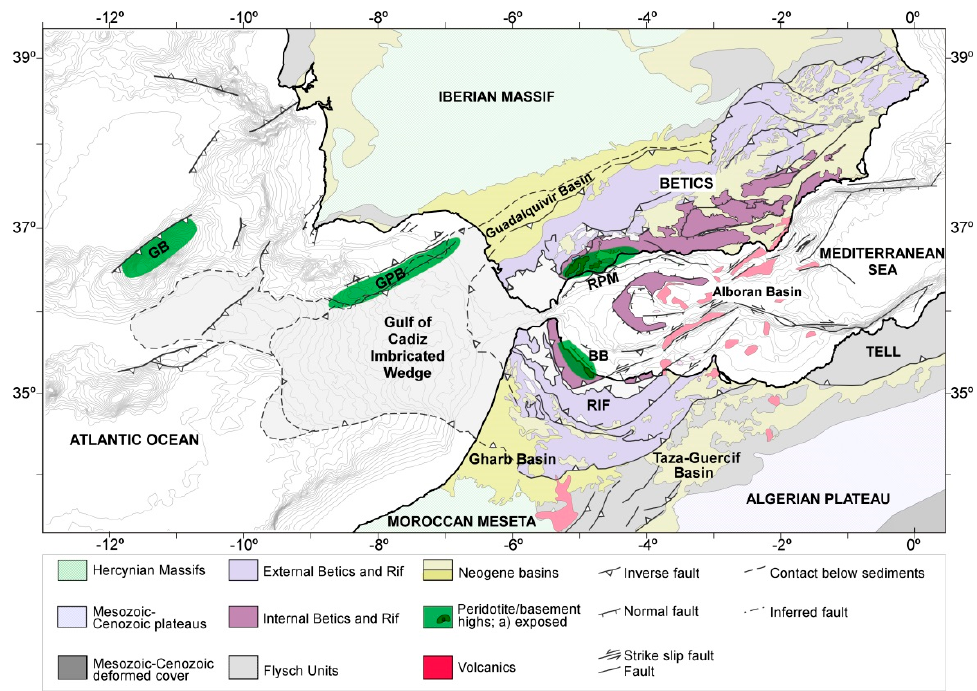
Figure 1. Simplified geologic and tectonic map of the Iberia–Africa plate boundary region modified from the works of [13,14]. Shaded green areas denote main compressive structures with outcropping or in-depth exhumed mantle rocks. GB: Gorringe Bank; GPB: Guadalquivir–Portimao Bank; RPM: Ronda Peridotite Massif; BB: Beni–Bousera peridotites.